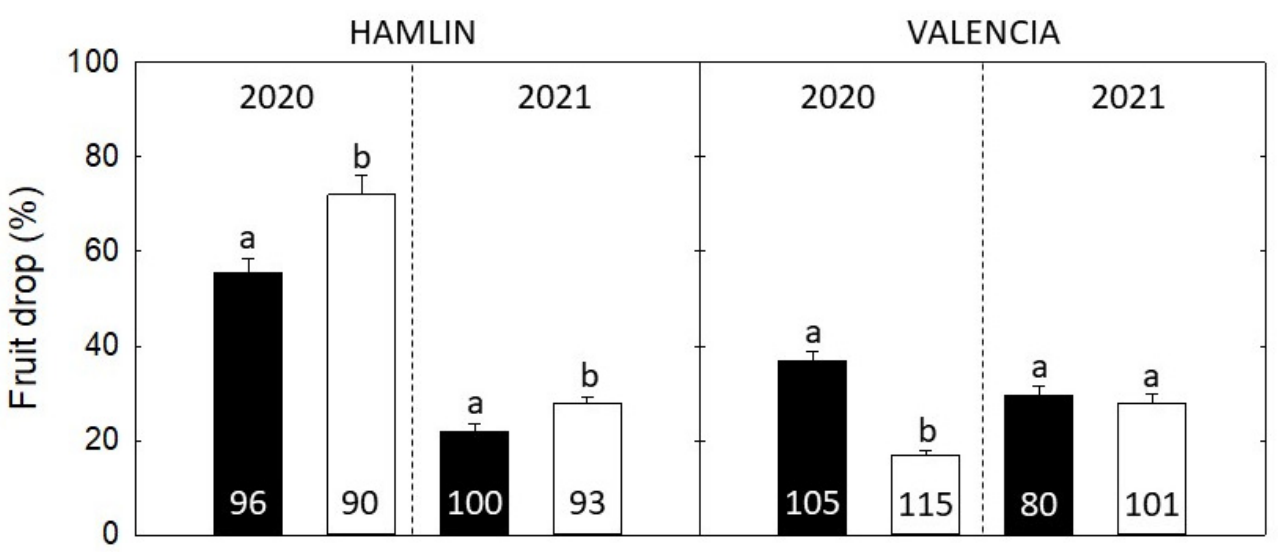
Figure 5. Percentage of fruit drop in Hamlin and Valencia scions grafted on Swingle ( ■ ) and US-942 ( □ )rootstocks in two di ff erent seasons. Data are means of four biological replicates. Error bars represent standard errors. Means with the same letter are not significantly different from each other at p -value < 0.05 according to Tukey-Kramer. Numbers within the bars are the average weight (g) of an individual fruit per rootstock–scion combination from a 30-fruit sample replicated 3 times.